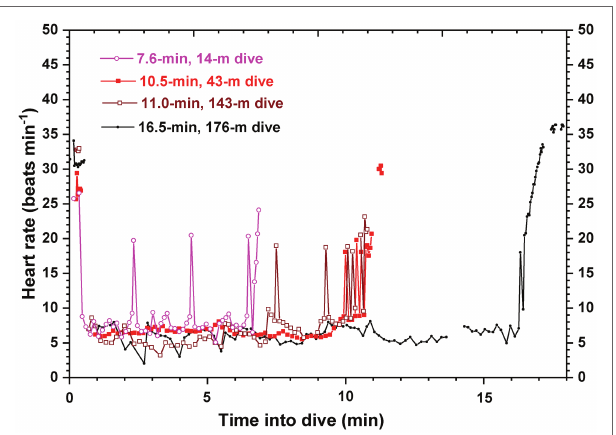
FIGURE 2 | Beat-to-beat heart rate profiles of four dives of a blue whale in Monterey Bay, CA. Heart rates were typically 4–8 beats min − 1 (bpm) during the bottom phases of both shallow and deep dives. Oscillations in heart rate were not uncommon. Pre- and post-dive heart rates after deep dives were near 35 bpm; for shallow, short duration dives, surface heart rates were typically 25–30 bpm. The allometrically predicted resting heart rate of a 70,000 kg blue whale was 15 bpm. Gaps in the heart rate profile were due to artifact in the ECG record. Adapted from the data of Goldbogen et al.